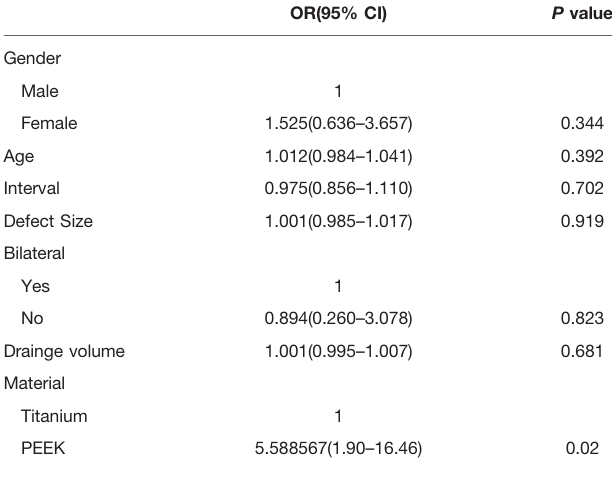
TABLE 3 | Binary logistic regression analysis for factors associated with subgaleal effusion.